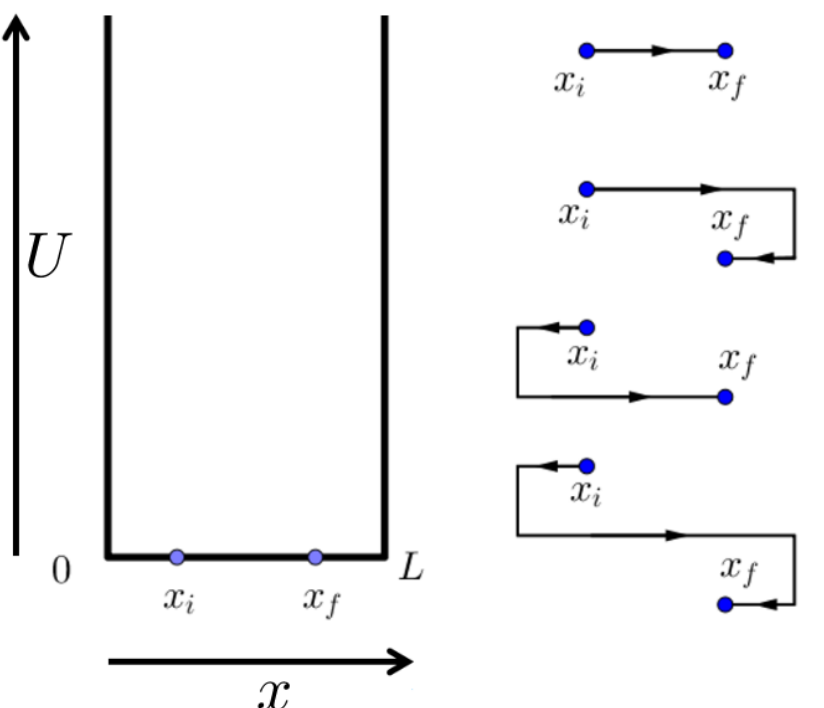
Figure 1. Left: a representation of the one-dimensional infinite square potential well with two points arbitrarily taken as initial, x i , and final, x f . As common in these representation, the vertical axis U is an energy scale. Right: the four basic possible routes exist from the source to the detector, including possible flections on the potential walls. Theoretically, all the paths that can be constructed by adding to any of the above an arbitrary number of full back and forth routes should be considered. Note that each reflection from a wall brings a e − i π contribution (inverts the sign) of the amplitude, associated to that path.